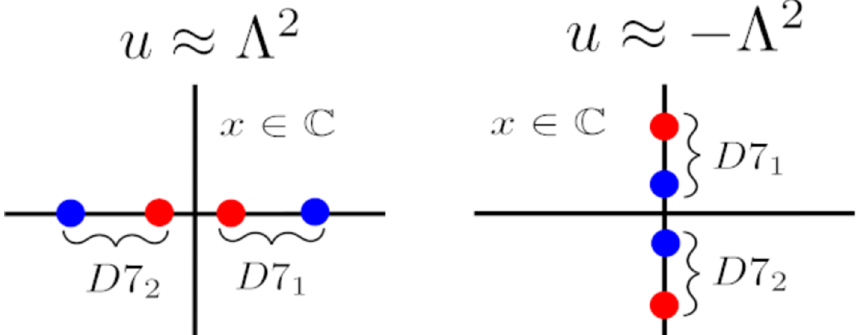
Figure 1 . The roots of W + ( x ) (blue) and W − ( x ) in the complex x -plane. A pair of roots of W + W − that coincides as Λ → 0 can be thought of as a perturbative D7-brane. Left: roots near the first singularity u → +Λ 2 . Right: roots near the other singularity u → − Λ 2